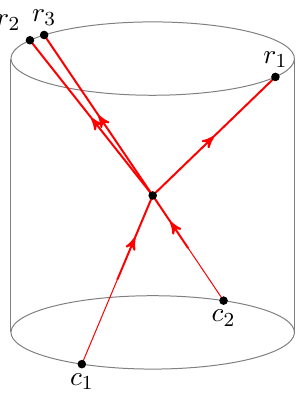
Figure 23. Counterexample to the naive generalization of the connected wedge theorem with 2 input and 3 output points. Input points c and c are place antipodally at time t = 0 , and output 1 2 points r and r are at time π , again antipodal but rotated a quarter turn. These four points 1 2 define input regions that are exactly on the transition between having connected and disconnected entanglement wedges. Adding an additional output point r makes one of the input regions smaller, 3 so that the wedge are disconnected, despite there being a 2 -to- 3 vertex in the